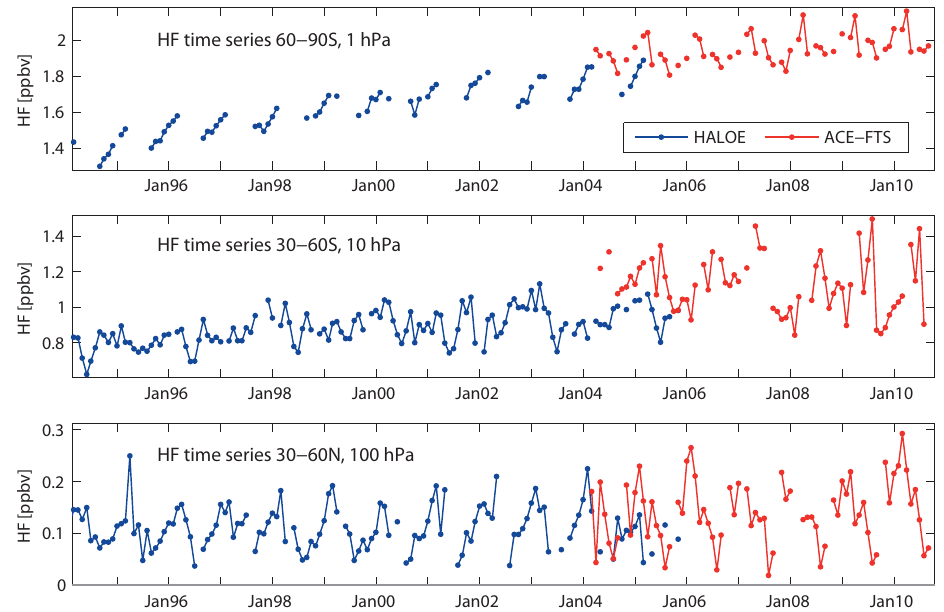
Figure 9. Time series of HF monthly mean values for 60–90 ◦ S at 1hPa (upper panel), 30–60 ◦ S at 10hPa (middle panel), and 30–60 ◦ N at 100hPa (lower